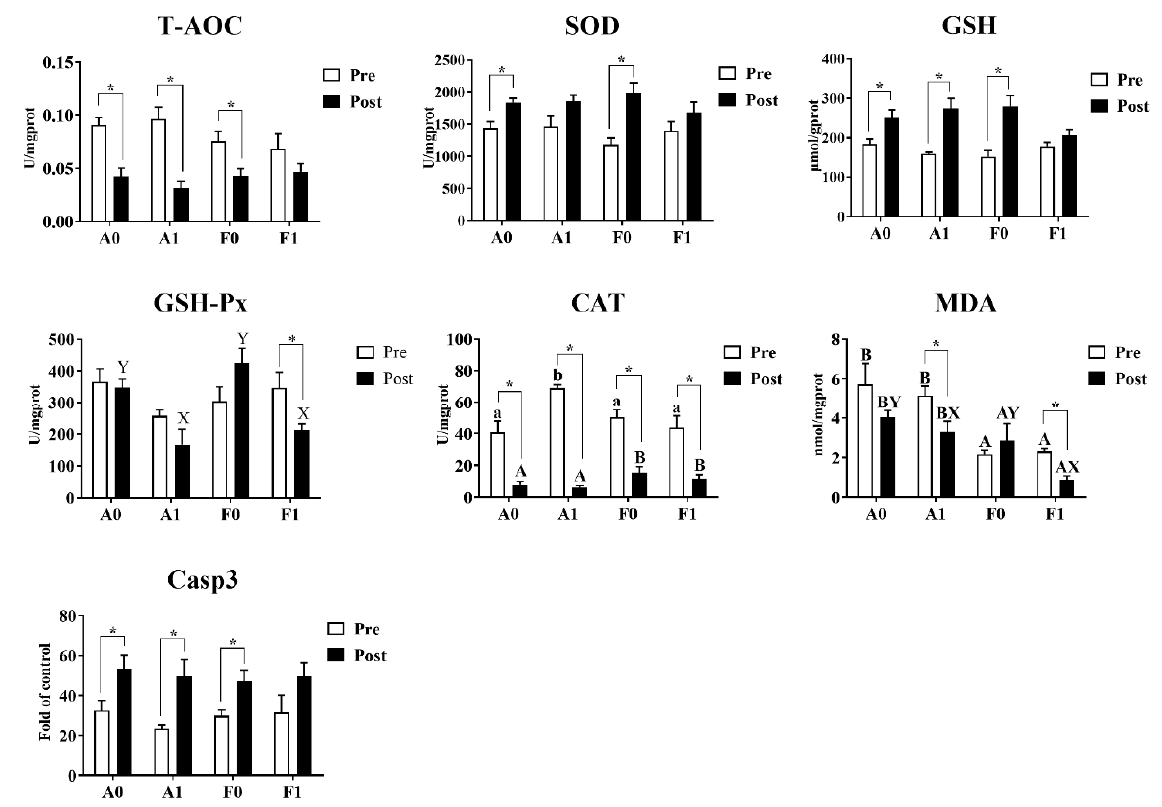
Figure 5. Antioxidant indices and Casp3 activity in the livers of gibel carp (A and F strains) before cadmium exposure (white bars) and after cadmium exposure (black bars). A0: A strain fed the control diet; A1: A strain fed a diet supplemented with taurine; F0: A strain fed the control diet; F1: A strain fed a diet supplemented with taurine. Bars with different uppercase letters (A, B) represent significant differences between the A and F strains ( p < 0.05). Bars with different uppercase letters (X, Y) represent significant differences between the control diet group and the taurine diet group ( p < 0.05). Bars with different lowercase letters (a, b) indicate the interaction effect and represent significant differences among all groups ( p < 0.05). Bars with * indicate significant changes between before and after cadmium exposure ( p < 0.05).